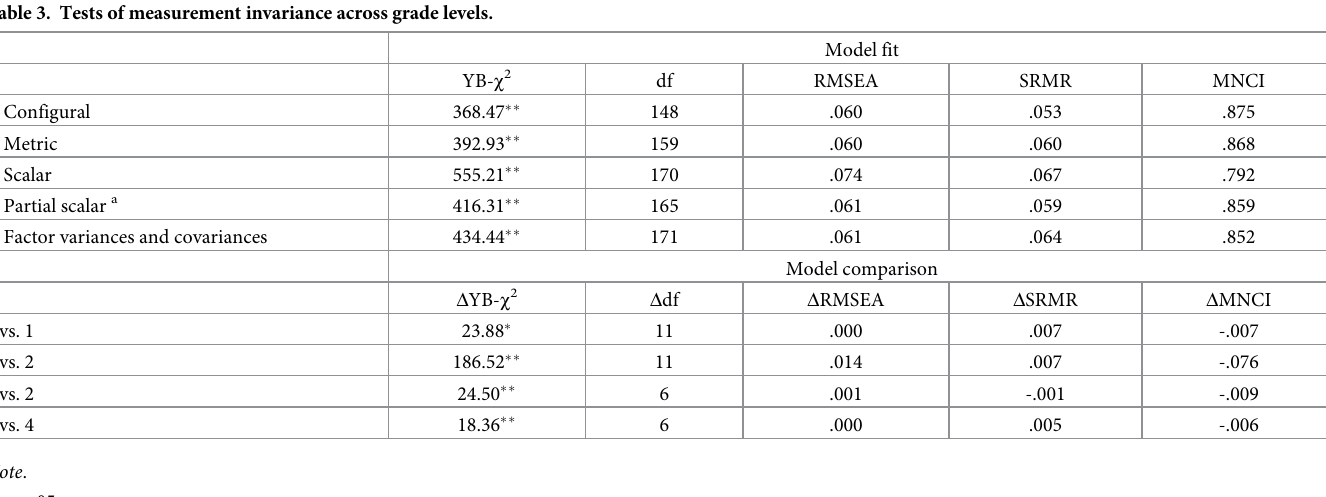
Table 3. Tests of measurement invariance across grade levels.